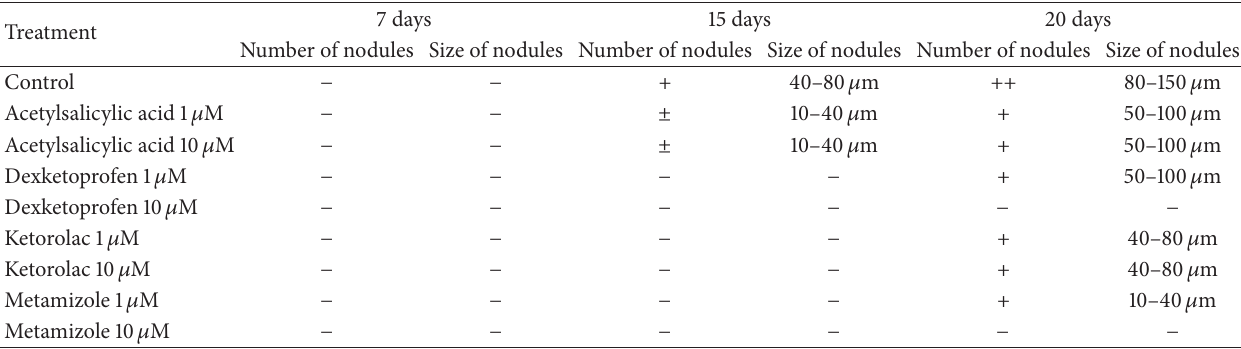
Table 5: Qualitative study of mineralization of MG63 cell line through formation of nodules, in relation to time, cultured in osteogenic medium supplemented with different NSAIDs: dexketoprofen, ketorolac, metamizole, and acetylsalicylic acid (1 and 10 𝜇 M).